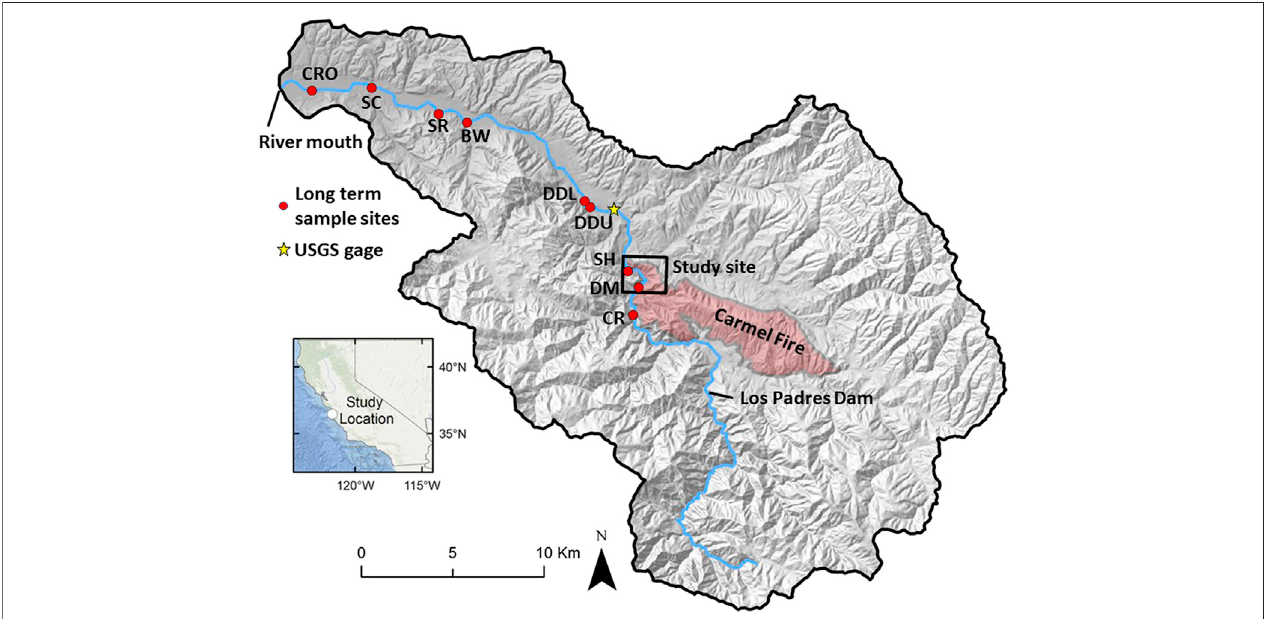
FIGURE 1 | Debris fl ow study site on a shaded relief map of the Carmel River watershed of central coastal California. Study site includes northwestern margin of 2020CarmelFire.FormerSanClementeDamsiteis30upstream(south)ofDMsamplesite.RedcirclesarelongtermsubstratesamplingsitesfullydescribedbyHarrison et al. (2018). Yellow star is USGS Robles del Rio stream gage site 11143200.